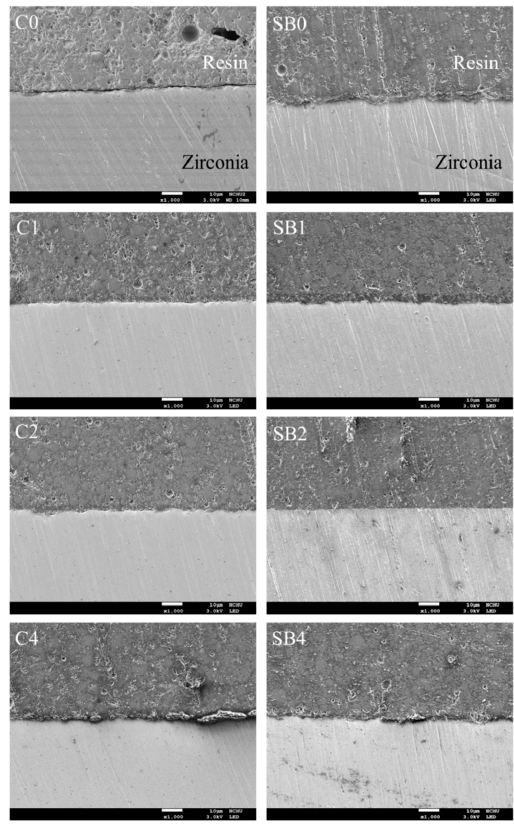
Figure 6. Cross-sectional SEM images of various plasma-treated zirconia bond to composite resin.